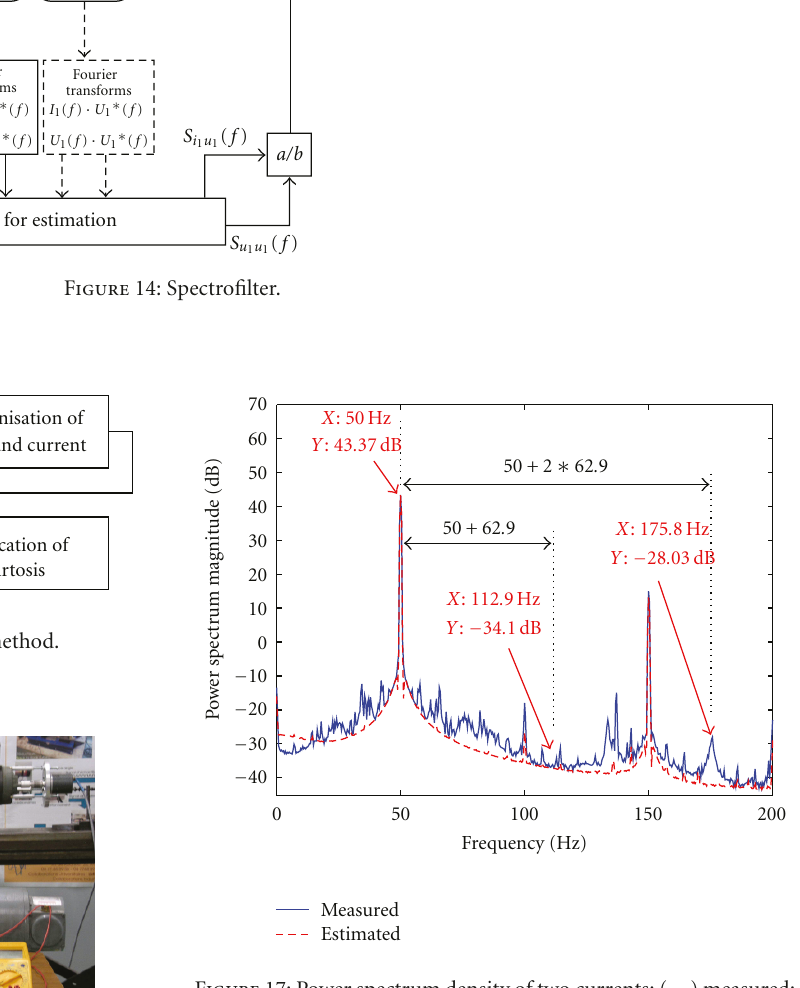
Figure 17: Power spectrum density of two currents: (—) measured; (- - - -) estimated with